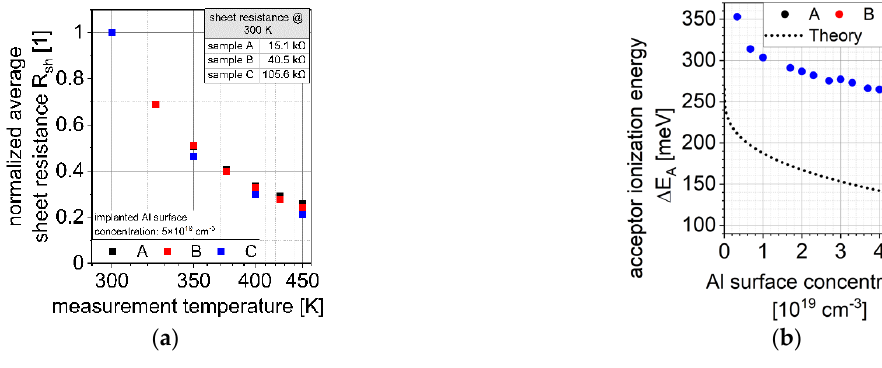
; ( b ) Determined effective 𝑅𝑅 𝑠𝑠ℎ